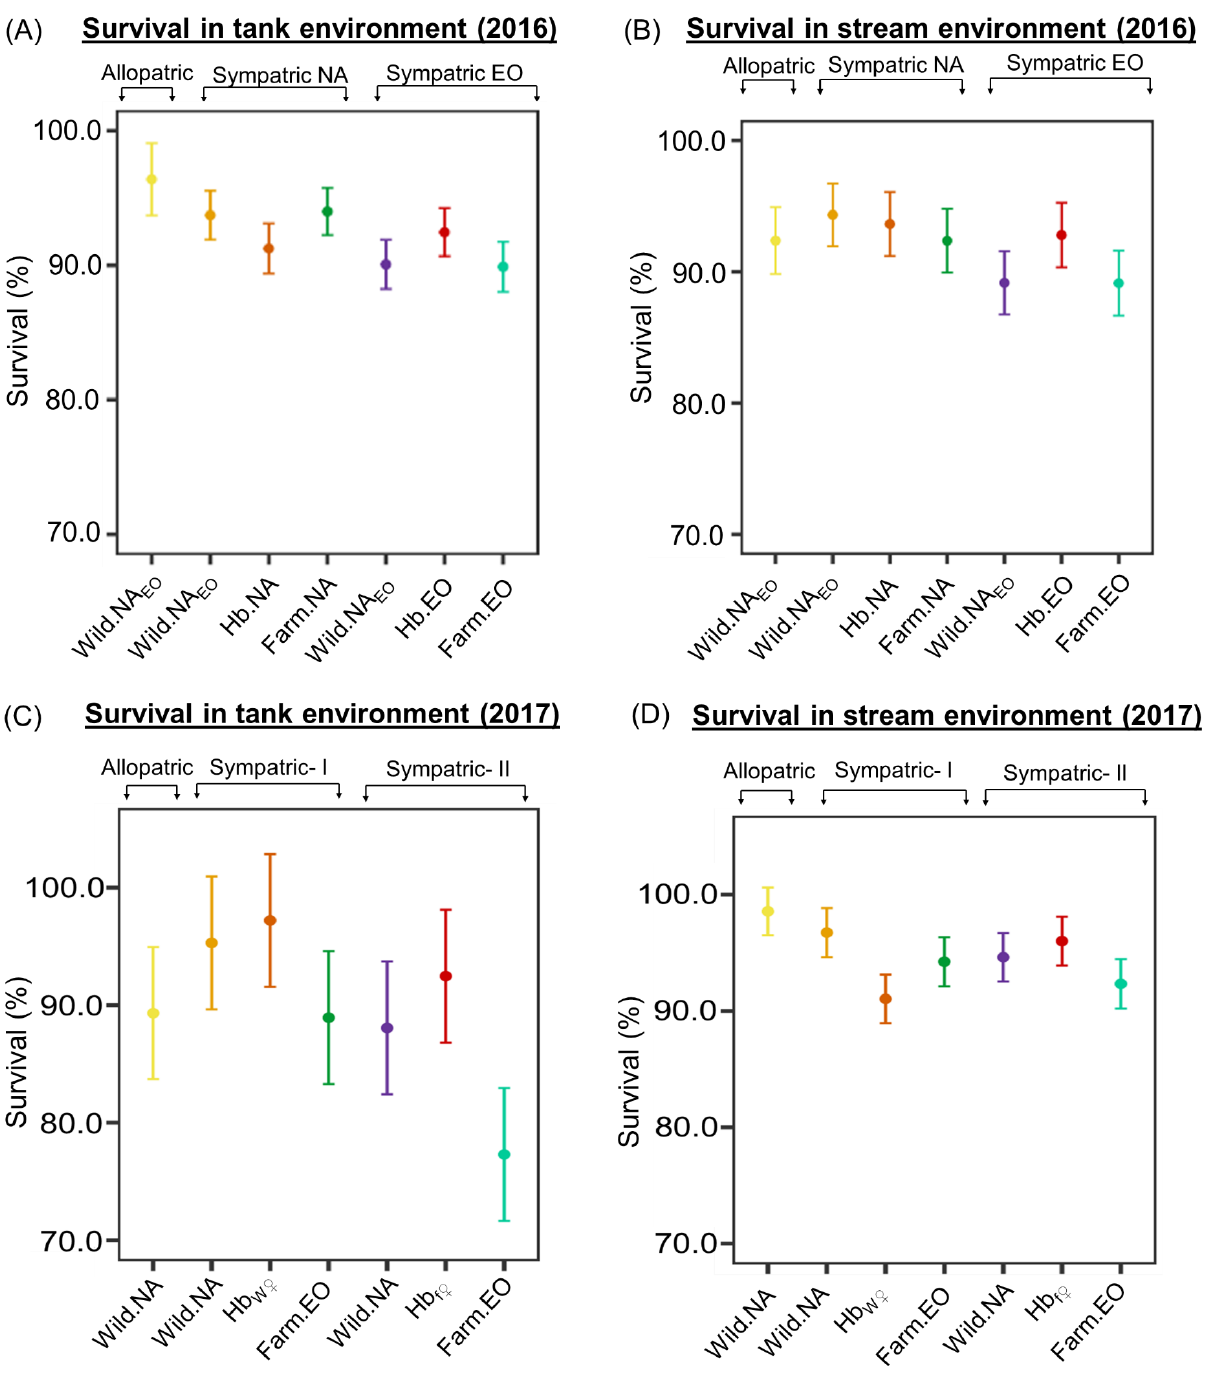
Table S4 for Tukey-adjusted pairwise contrasts among cross types fitted in the final models. See Fig. 2 for cross allopatry versus sympatry in the tank environment; Given the difference in dominance, one might neces- in however, in the stream environment, Wild.NA sarily expect a growth difference between allopatric EO sympatry (Sympatric NA; i.e. competing with Farm.NA and sympatric wild in the tank environment, as the and Hb.NA) outgrew their counterparts in allopatry. tank environment is somewhat more benign than